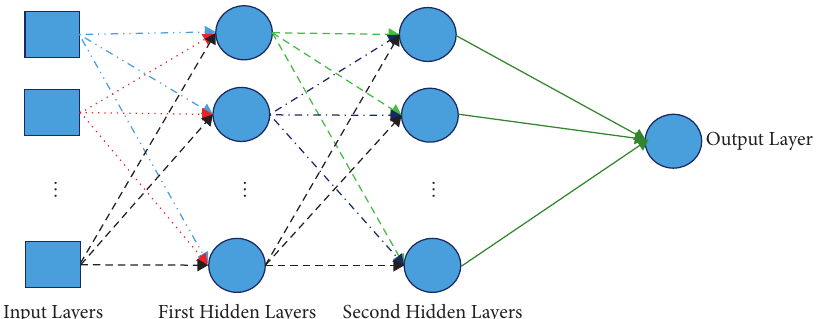
Figure 1: The schematic structure of the MLP model.